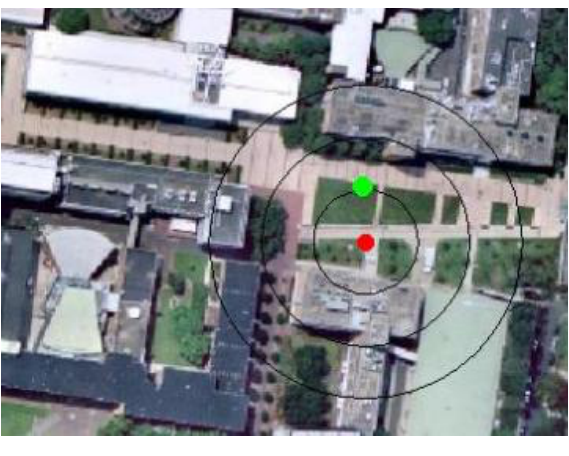
Figure 15. Positioning result for the query image shown with green dot. The red dot indicates the location determined by the GPS, with the black circles show the process to enlarge the search space (1–3 times of its horizontal